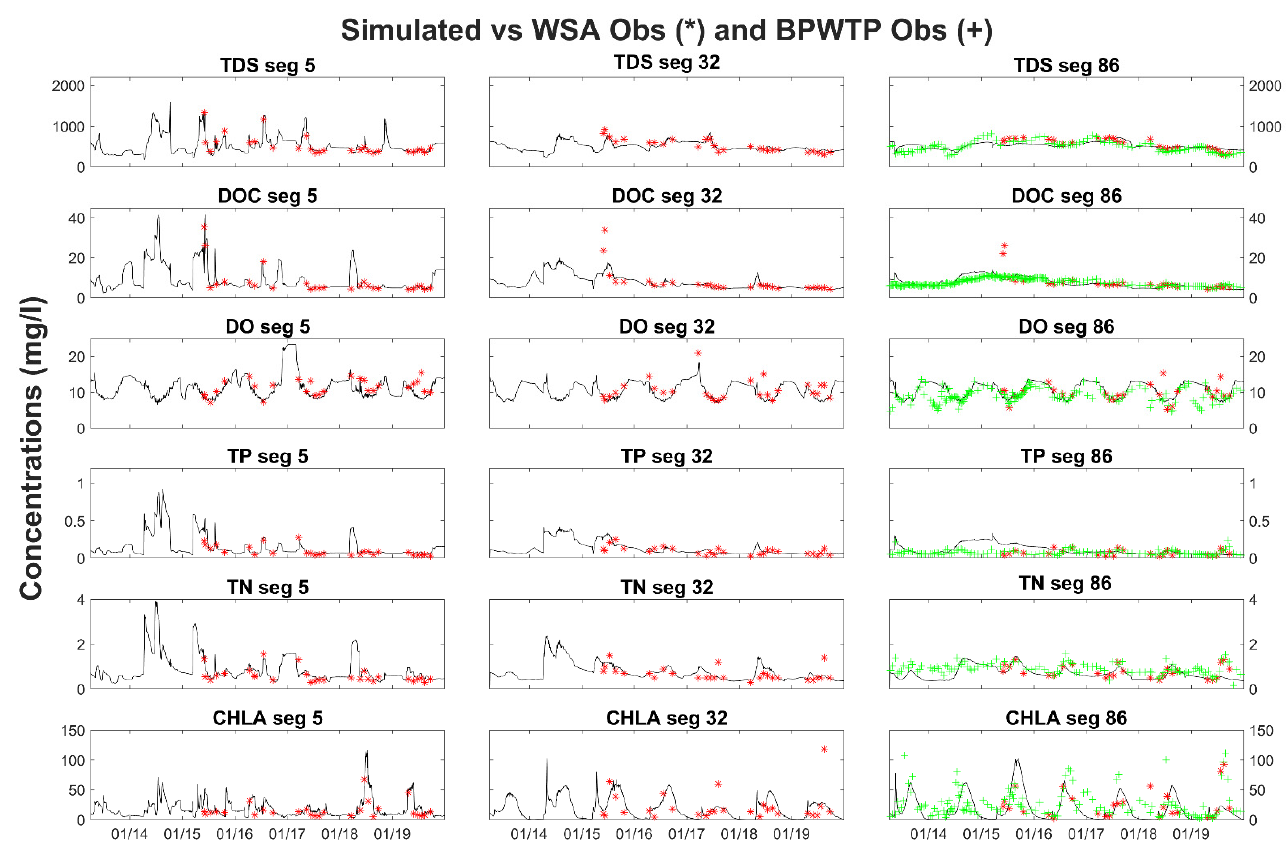
Figure 4. Model results for BPL for the calibration period April 2013–December 2019. Segment 5 is located upstream in the top section of lake. Segments 32 and 86 are both located in the main body of the lake. Water Security Agency observed in-lake sample data (red *) are included from June 2015. Observed weekly data provided by the Buffalo Pound Water Treatment Plant (green +) are shown in segment 86. Inflow constituents DO = dissolved oxygen, and CHLA = Chlorophyll-a.